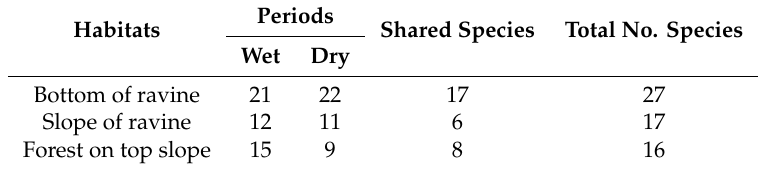
Table 3. Numbers of species in ravine habitats in climatically di ff erent conditions. Habitats